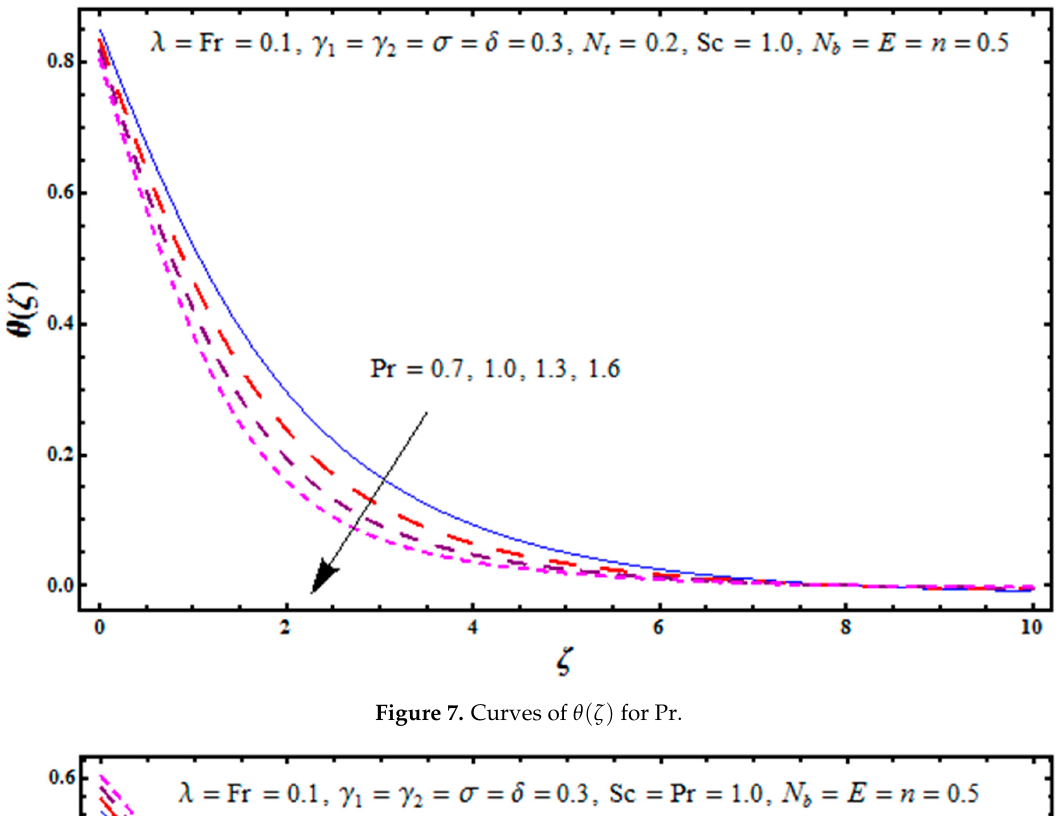
Figure 7. Curves of θ ( ζ ) for Pr.